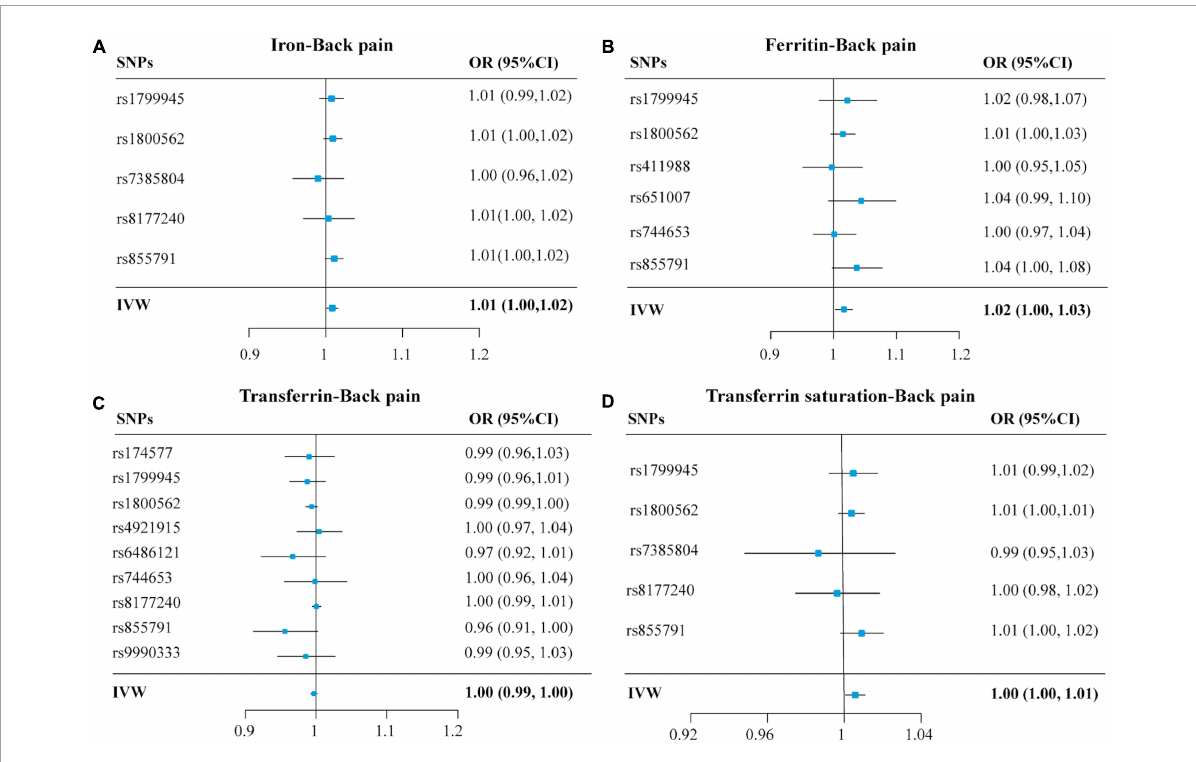
FIGURE3 Forest plots summarizing the selective SNPs and overall MR estimates for the causal effects on back pain using the SNPs associated with four iron biomarkers in liberal analyses. Panels (A–D) , respectively, indicate the causal estimates of serum iron, ferritin, transferrin, and transferrin saturation on back pain. The horizontal lines represent the 95% CIs, while the solid black diamonds represent estimates of the causal effects of the genetic instruments. The gray diamond’s center indicates the overall MR estimate, while the diamond’s width indicates the 95% CIs. MR, Mendelian randomization; SNP, single nucleotide polymorphisms; OR, odds ratio; CI, confidence interval; IVW, inverse variance weighted.